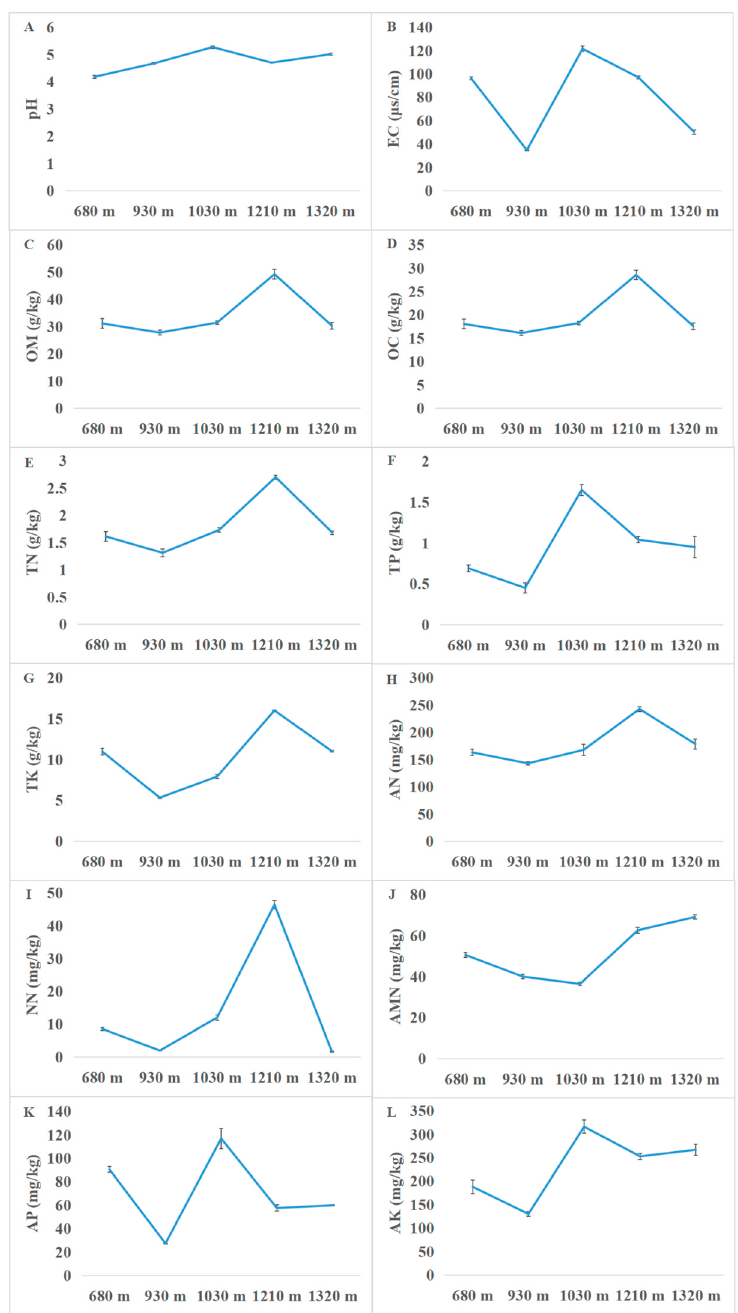
Figure 1. Physicochemical properties of C. arabica rhizospheric soil at different altitudes. ( A ) the pH of C. arabica rhizospheric soil at different altitudes; ( B ) the electrical conductivity of C. arabica rhizospheric soil at different altitudes; ( C ) the organic matter content of C. arabica rhizospheric soil at different altitudes; ( D ) the organic carbon content of C. arabica rhizospheric soil at different altitudes; ( E ) the total nitrogen content of C. arabica rhizospheric soil at different altitudes; ( F ) the total phosphorus content of C. arabica rhizospheric soil at different altitudes; ( G ) the total potassium content of C. arabica rhizospheric soil at different altitudes; ( H ) the available nitrogen content of C. arabica rhizospheric soil at different altitudes; ( I ) the nitrate nitrogen content of C. arabica rhizospheric soil at different altitudes; ( J ) the ammonium nitrogen content of C. arabica rhizospheric soil at different altitudes; ( K ) the available phosphorus content of C. arabica rhizospheric soil at different altitudes; ( L ) the available potassium content of C. arabica rhizospheric soil at different altitudes. OM, OC, TN, TP, TK, AN, NN, AMN, AP, and AK represent organic matter, organic carbon, total nitrogen, total phosphorus, total potassium, available nitrogen, nitrate nitrogen, ammonium nitrogen, available